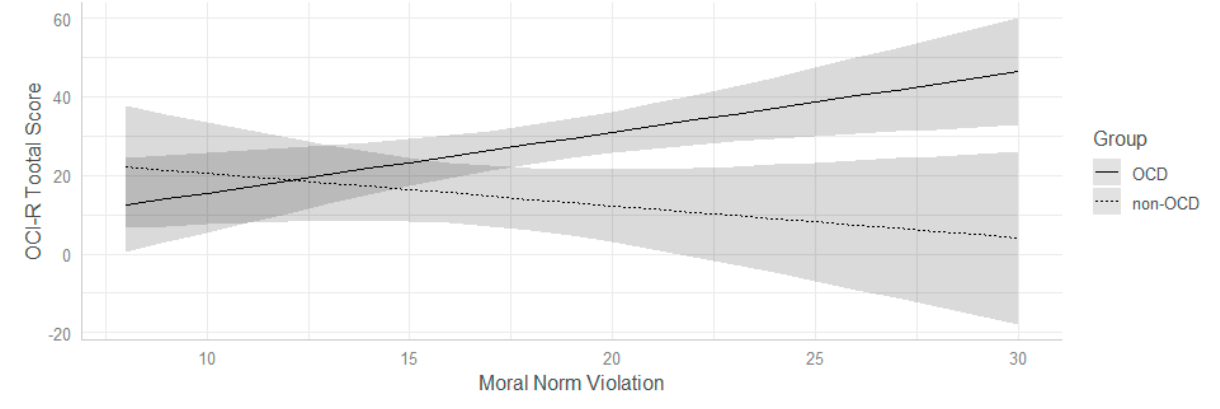
Figure 1. Moral Violation Norm × group interaction on total scores of OCI-R. Grey areas represent confidence intervals. OCI-R Total Score= Obsessive Compulsive Inventory – Revised (Total Score).